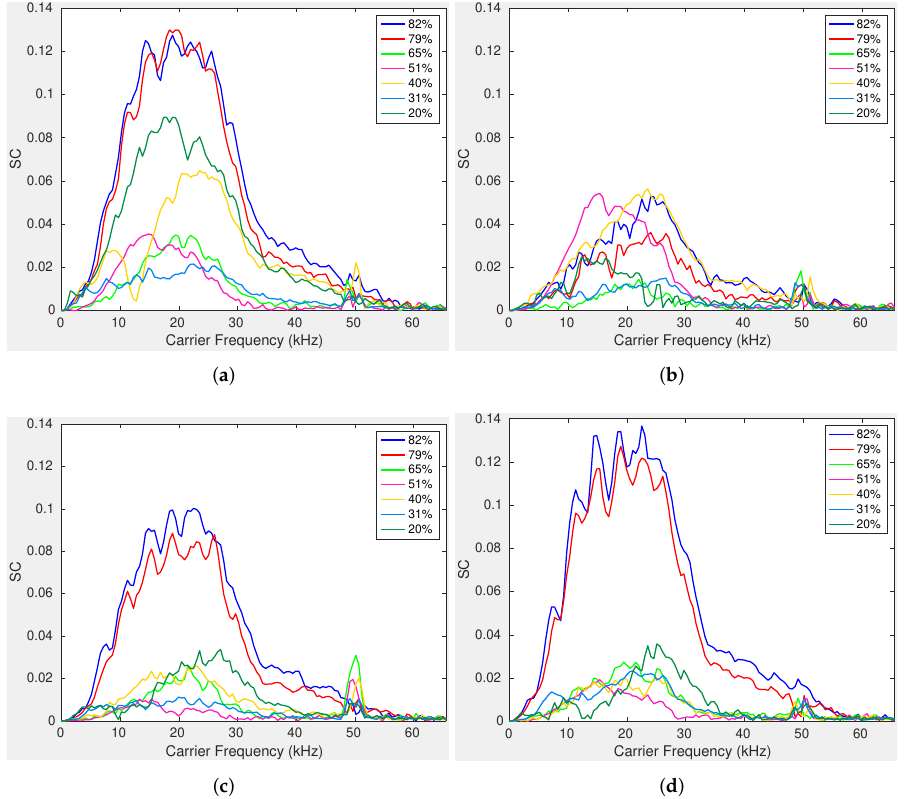
Figure 11. The spectral coherences (SC) γ ( α , f c ) of the ( a ) first, α = SF 1, ( b ) second, α = SF 2, ( c ) third, α = SF 3, and ( d ) fourth, α = SF 4, harmonics of shaft frequency across the entire carrier frequency f c range at different propeller pitch ratios, ranging from 20% to